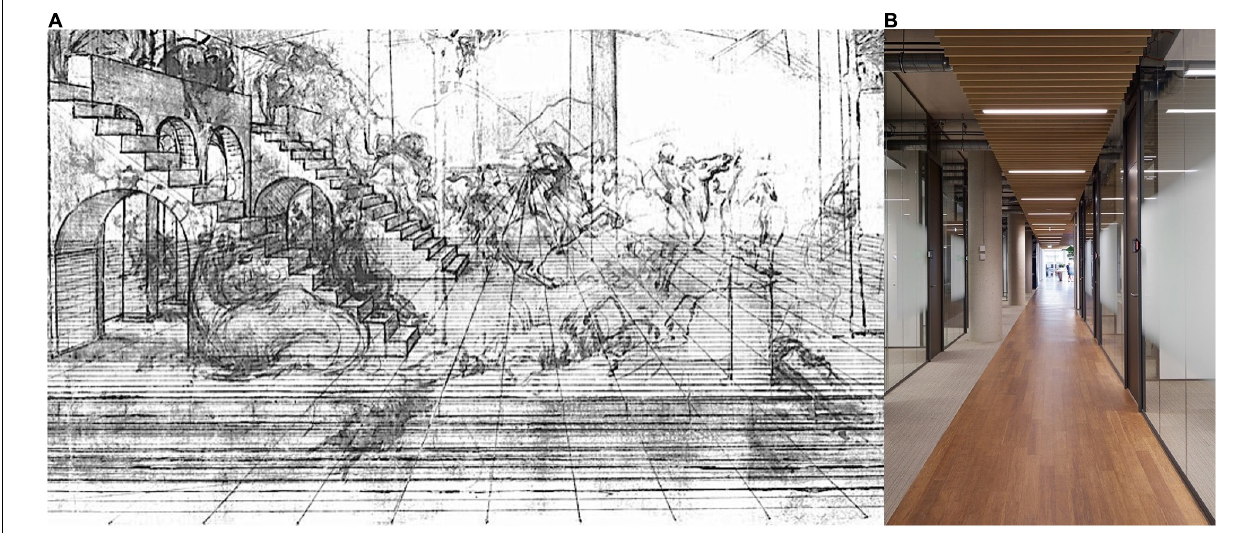
FIGURE 8 | (A) The first extant perspective diagram (from Leonardo da Vinci, ∼ 1,475) illustrating the principle of the vanishing point. Note how the ground plane appears to slant upward rather than extending purely horizontally. (B) A vivid depth percept from a parallel corridor, a 3D form of a distortion